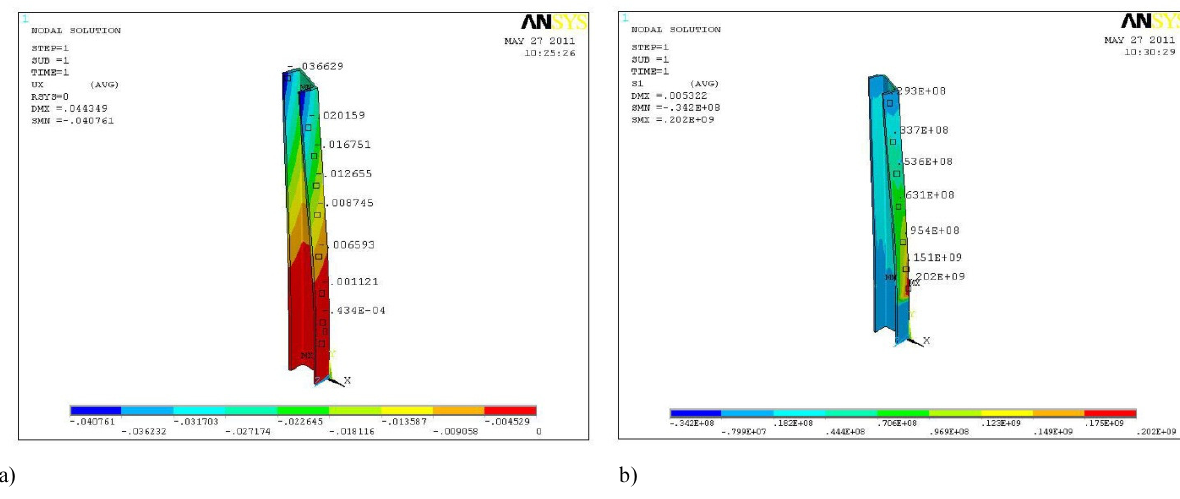
Fig. 12. The post MST-3 mounted on a bridge or a viaduct: a – deflections, b – stresses (our